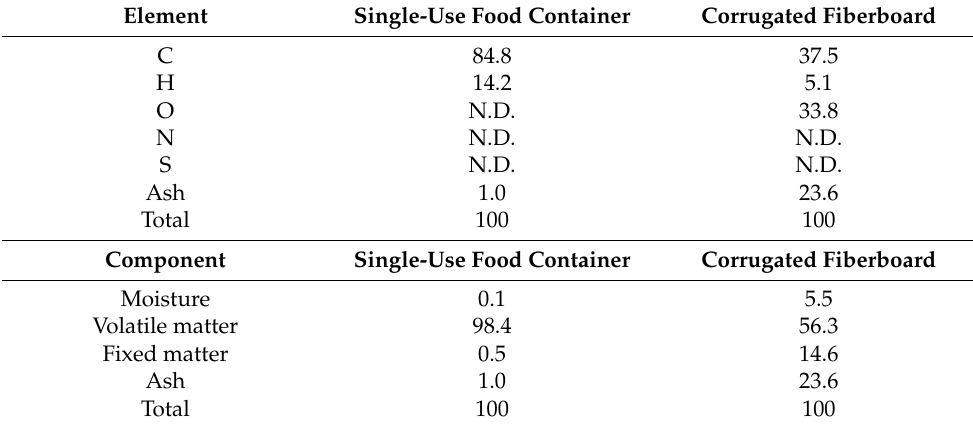
Table 2. Results of proximate and ultimate analysis of the single-use food containers and corrugated fiberboard (unit: wt.%).